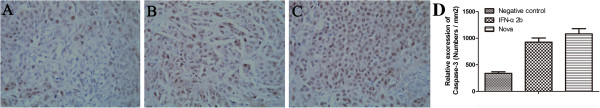
The immuno histochemical analysis result of caspase 3 in each group. Caspase-3 protein increased in dissected tumor tissues after mice was treated by IFN-α2b (B) and Nova (C) compared with the negative control (A). D is quantization of the expression of the proteins evaluated in the different samples with immunohistochemistry.